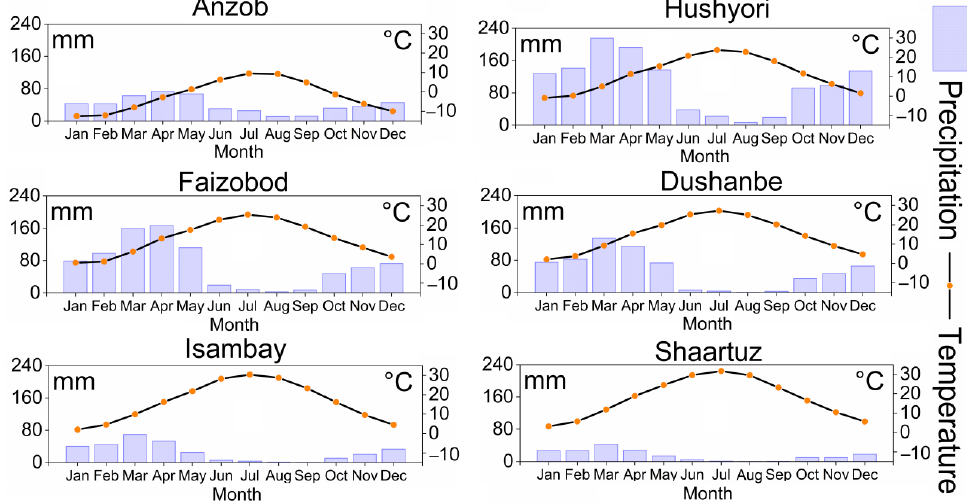
Figure 2. Inter-annual variations in temperature and precipitation during the 1951–2012 period in the Kofarnihon River Basin, Central Asia. Kofarnihon River Basin, Central